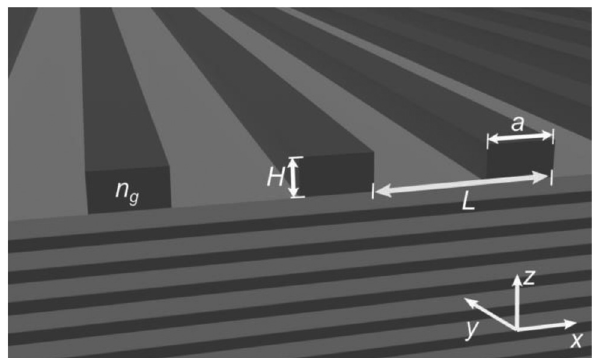
Figure 1: Schematic cross-section of a grating implemented on a DBR. The geometrical parameters of the grating and coordinate system are defined graphically. The refractive index of the grating and the larger refractive index of the DBR (dark grey) are both n H = 3.52; the lower refractive index (light grey) is n L = 2.2.